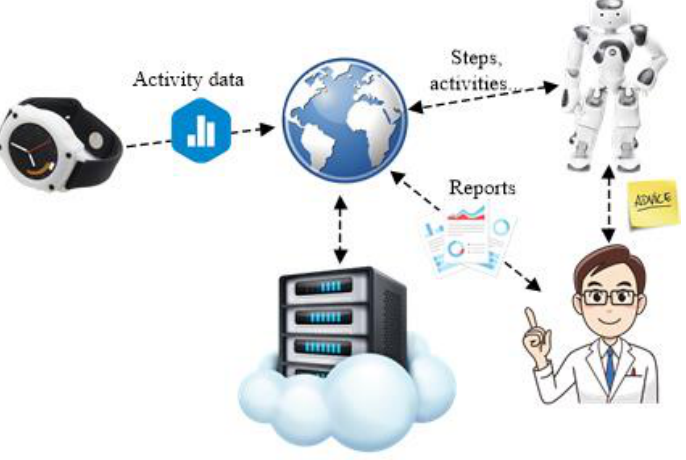
Figure 5. The interaction between the obesity management system components.